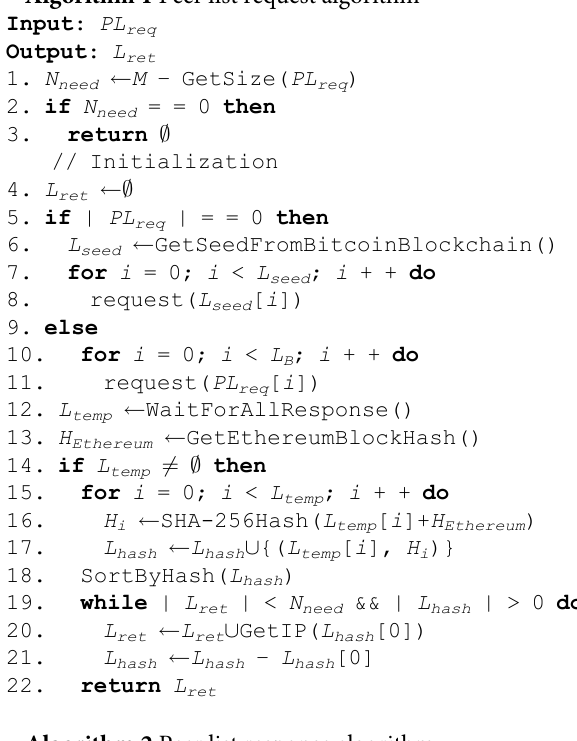
Algorithm 2 Peer list response